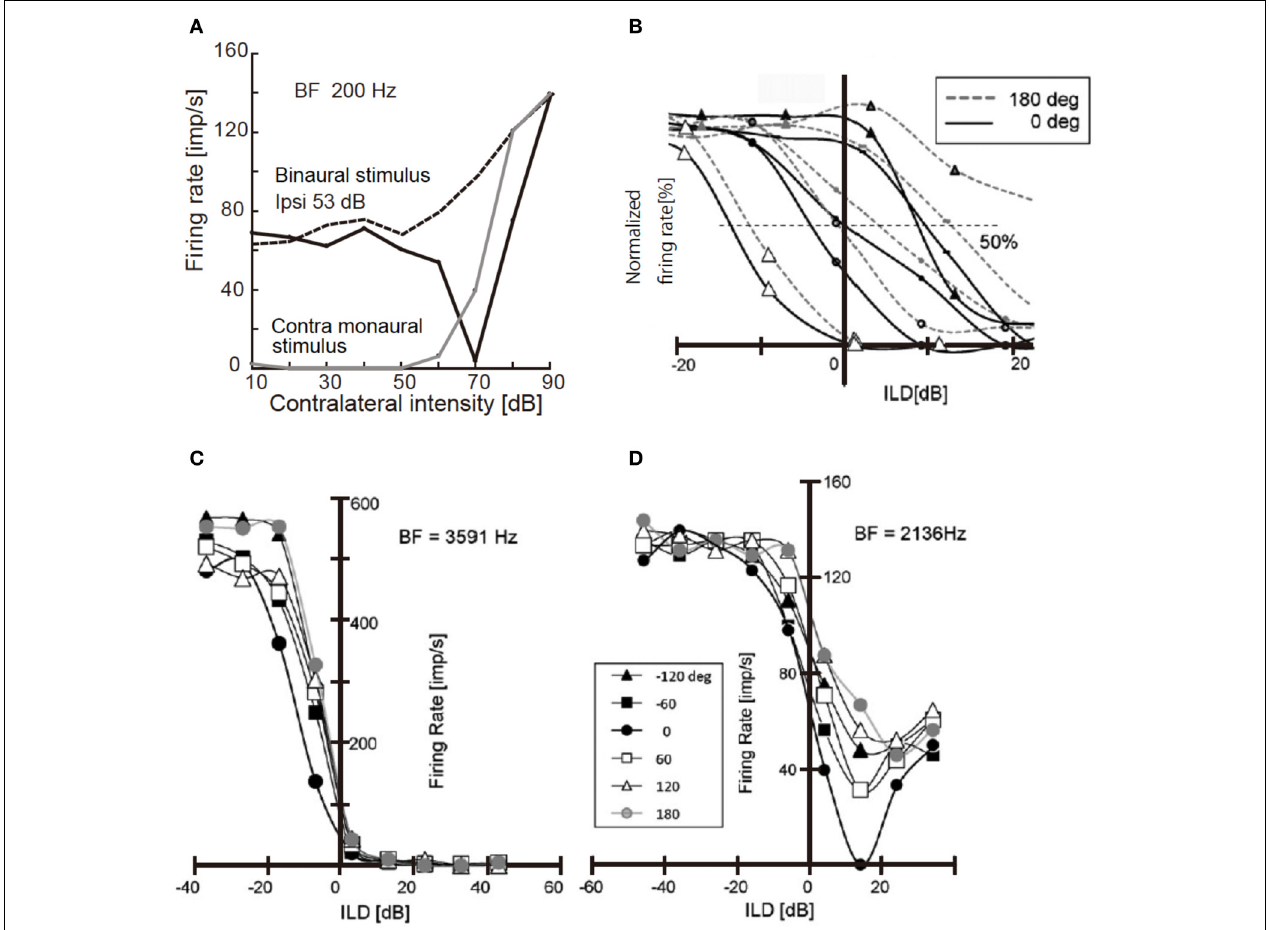
FIGURE 2 | Responses of NA unit and LLDp units to binaural stimuli. (A) Response of NA units to contralateral tone of 200Hz. Binaural stimulus was applied in-phase (solid black line) or 180 ◦ out of phase (dotted line) with a constant ipsilateral tone of 53dB; 20dB above the threshold. Responses induced by contralateral monaural stimulus are included (solid gray line). (B) Rate-ILD relationship of LLDp units. ILD was defined as ipsi-contra SPL